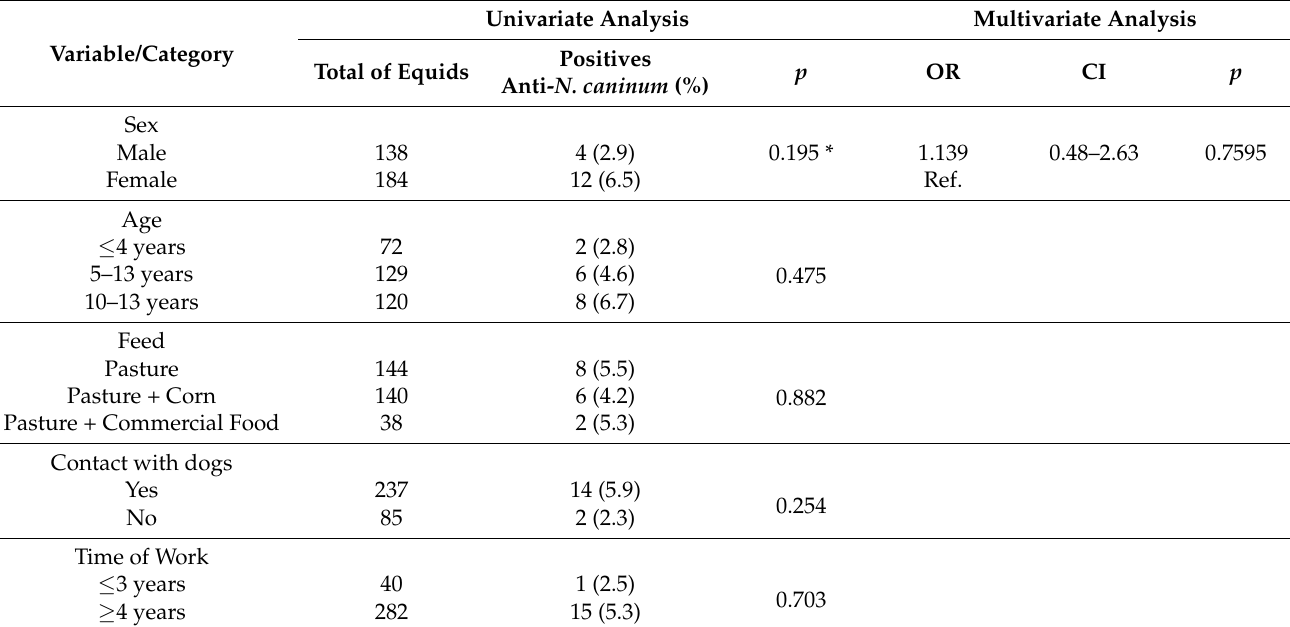
Table 4. Univariate and multivariate analyses of risk factors associated with the positivity for anti- Neospora caninum antibodies in traction equids in the semi-arid region of Northeastern